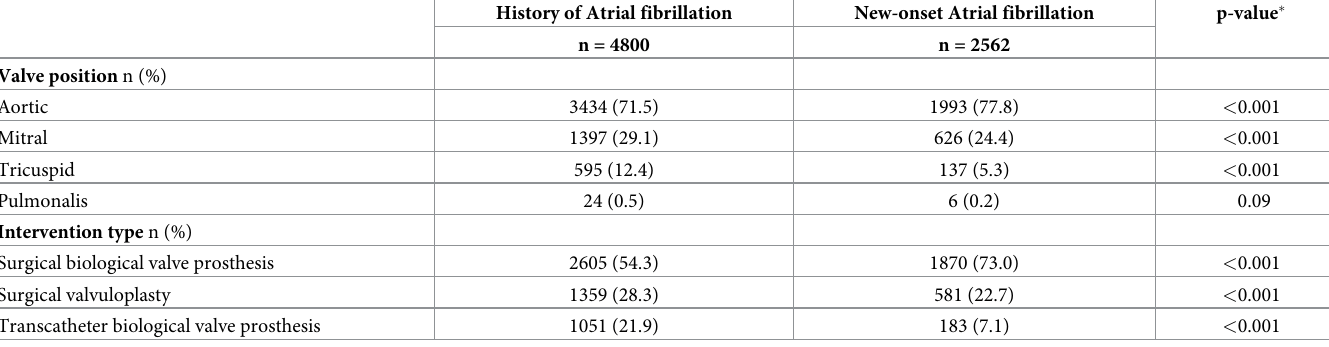
Table 2. Valve position and intervention type in the previous history and new-onset atrial fibrillation groups.